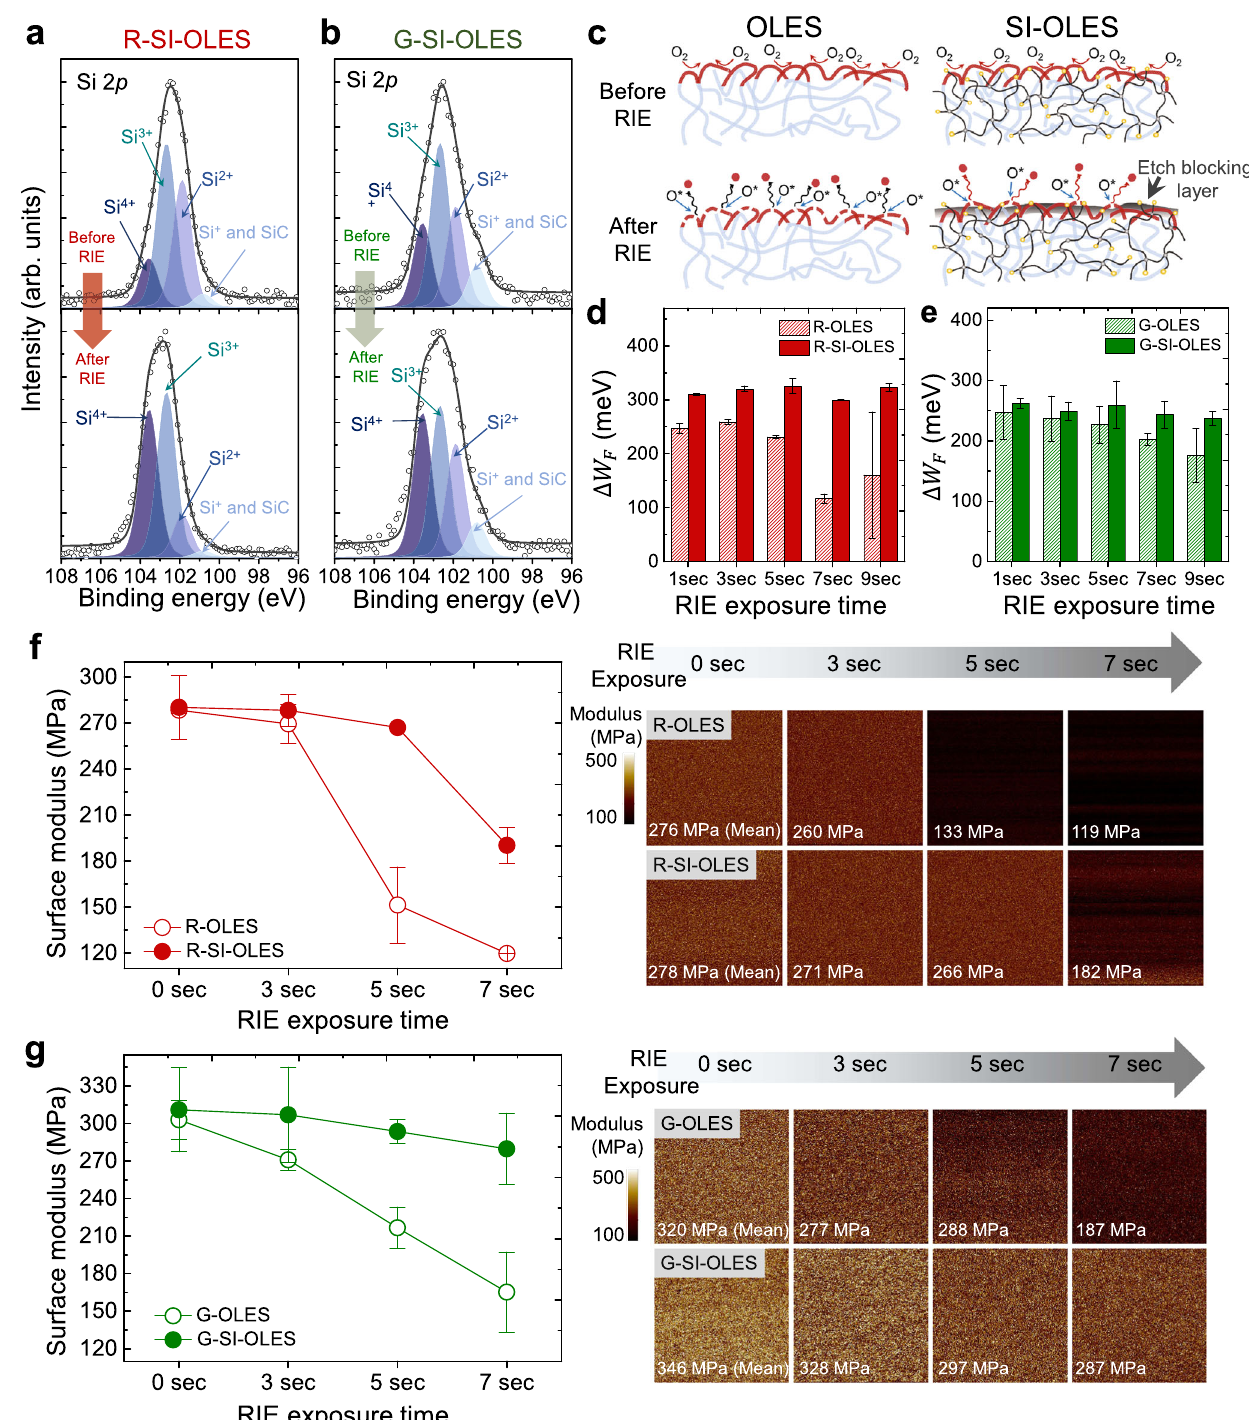
Fig. 2 | Analysis of the non-volatile EBL of the SI-OLESs. a , b XPS analysis of the surface atomic structure of the R- and G-SI-OLES based on exposure of reactive etchinggases. c SchematicillustrationofthechemicaletchingmechanismoftheSI- OLESwith the non-volatile EBL. d , e Variation of increased work functions ofthe R- and G-OLES/SI-OLES fi lms as a function of reactive etching times, respectively.